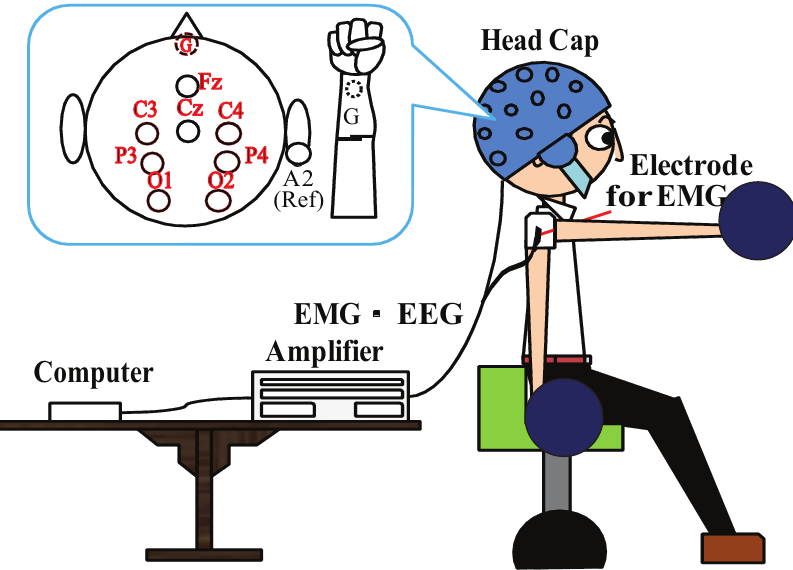
Figure 1. Measurement of EEG and EMG signals. A participant in the experimental trial is sitting on a chair with the eyes open and performing flexion and extension of the shoulder joint with a weight of 3 Kg. The movement is conducted for a duration about 60–80 times, consecutively within 5 min with their own pace. He wears an EEG measurement cap, the electrodes fixed on the cap and an electrode for the measurement of EMG signal are connected to the EEG amplifier and EMG amplifier, respectively. The amplified data are transmitted to the computer after the analog/digital(A/D) conversion and